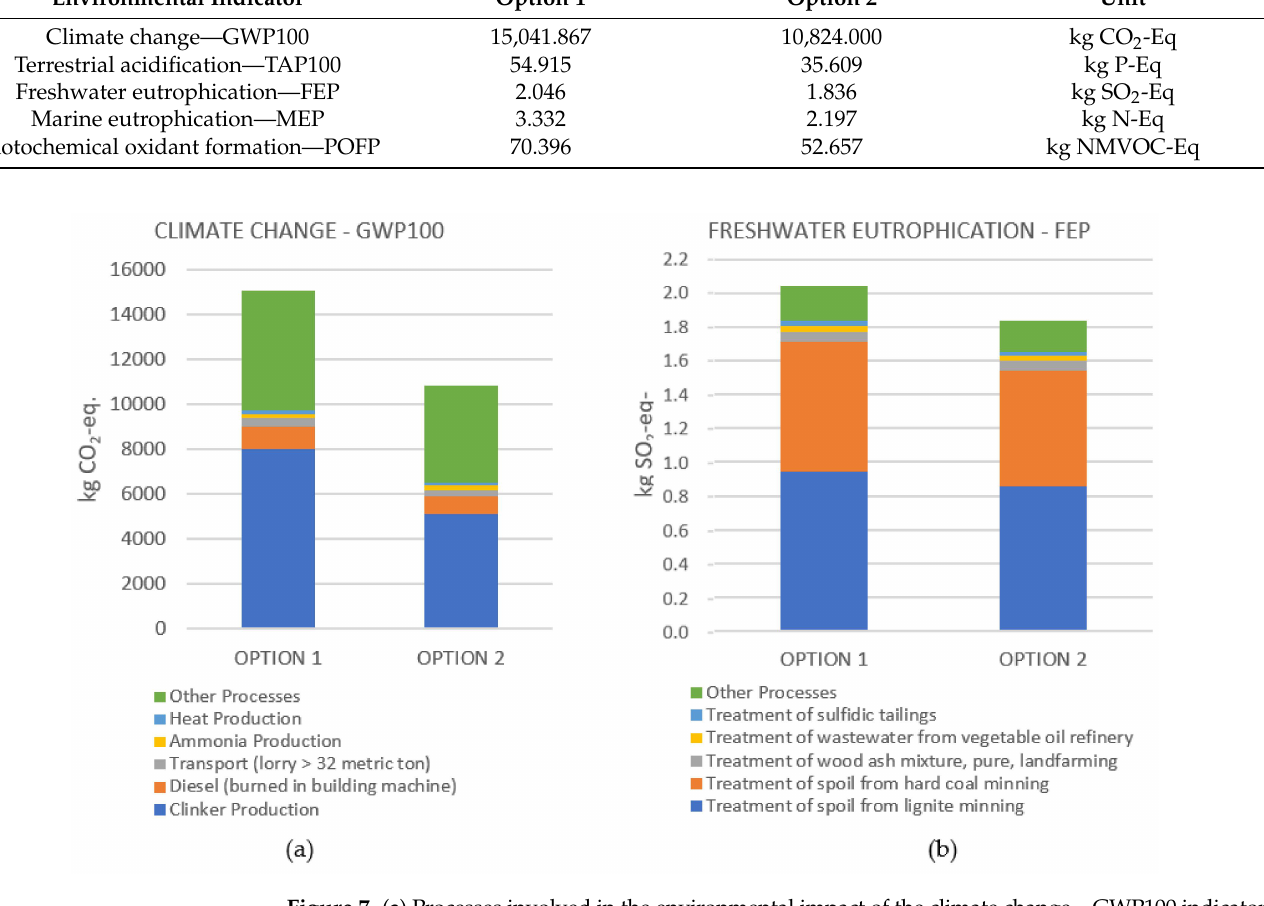
Figure 7. ( a ) Processes involved in the environmental impact of the climate change—GWP100 indicator; ( b ) processes involved in the environmental impact of the freshwater eutrophication—FEP